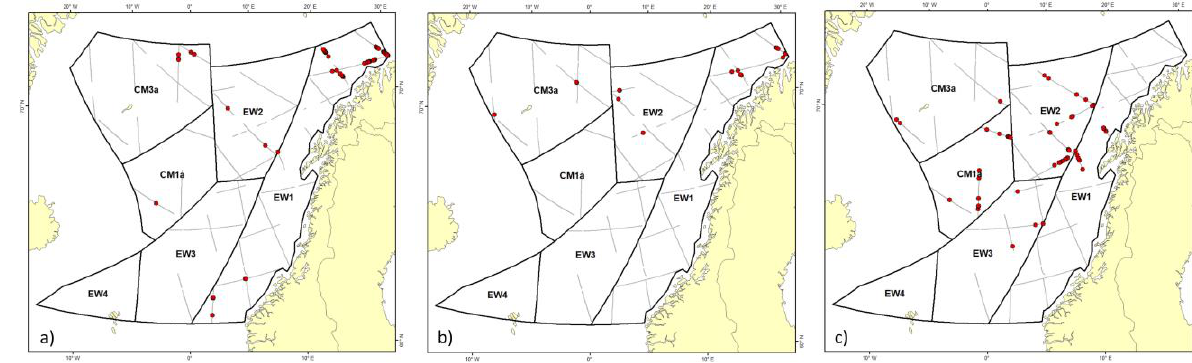
Figure 14. 2015 NASS extension survey sightings: (a) fin whale sightings, (b) humpback whale sightings, and (c) sperm whale